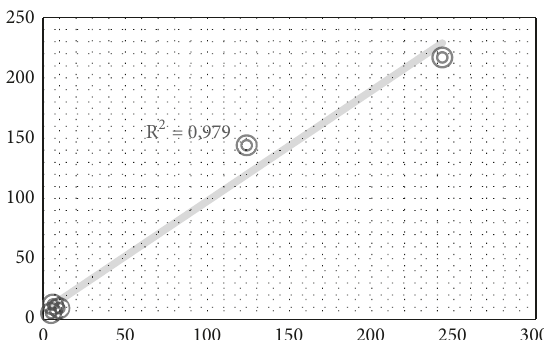
Figure 3: Validation of the tool versus analysis of professional in hematology.